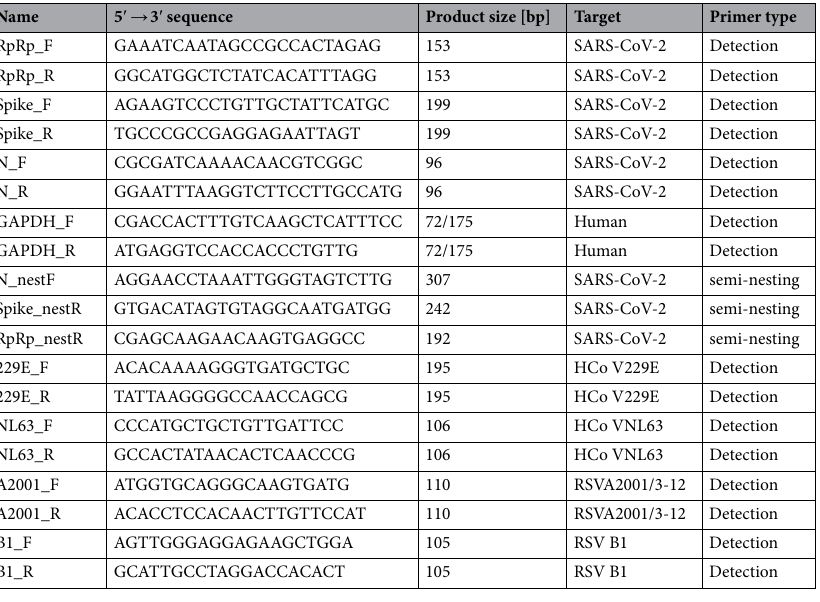
Table 1. Sequences and chosen properties of the primers used in this